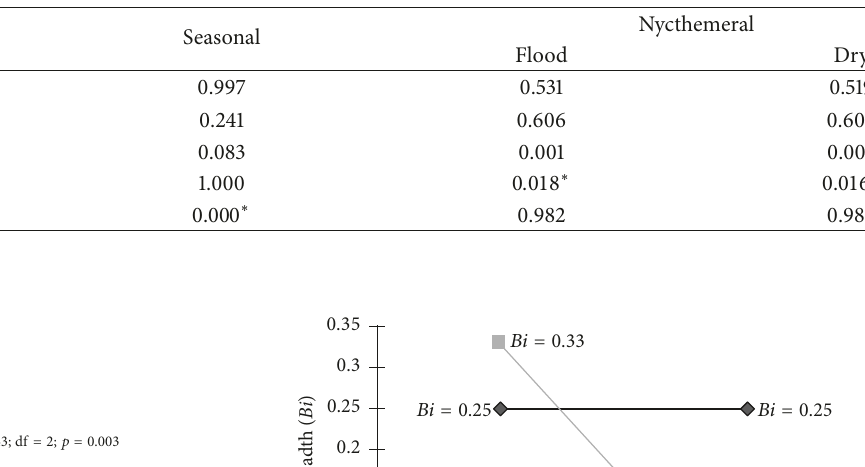
Table 2: Mean observed and simulated Pianka indices and their respective p values for the dietary overlap of S. gibbus and S. rhombeus in the Coaracy Nunes reservoir in Ferreira Gomes, Amap´a (Brazil).